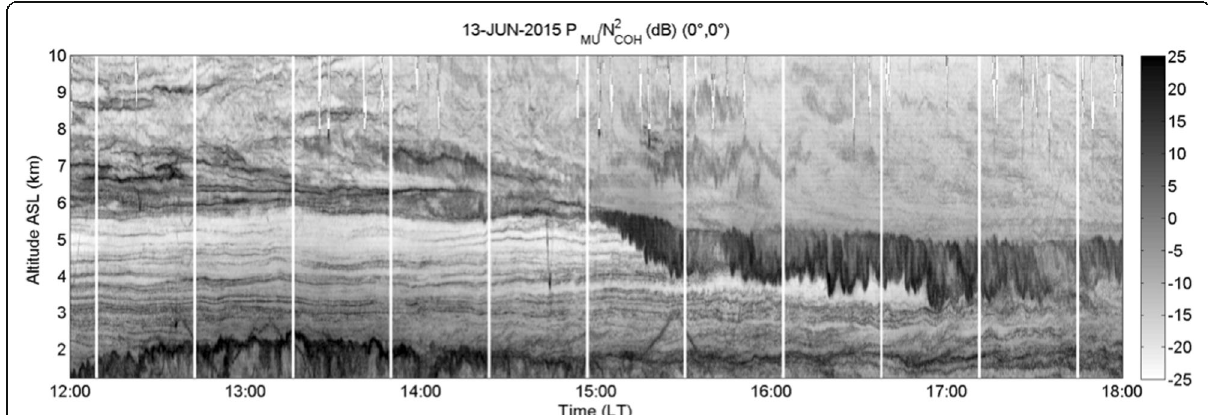
Fig. 3 As in Fig. 1 but from 12:00 to 18:00 LT on June 13, 2015, during the ShUREX 2015 campaign. The layer between the two high humidity gradient sheets evolves into MCT around 15:00 LT, presumably due to precipitation from within the cloud falling into dry air below the cloud base, evaporating and triggering instability and strong convection. The top of the MCT layer is the cloud base, and a strong jump in the refractive index gradient occurs there. CBL with strong convective plume activity penetrating above 2 km altitude can also be seen between 12:00 and 14:00 LT. Inverted V tracks of the UAV can be seen in and above the